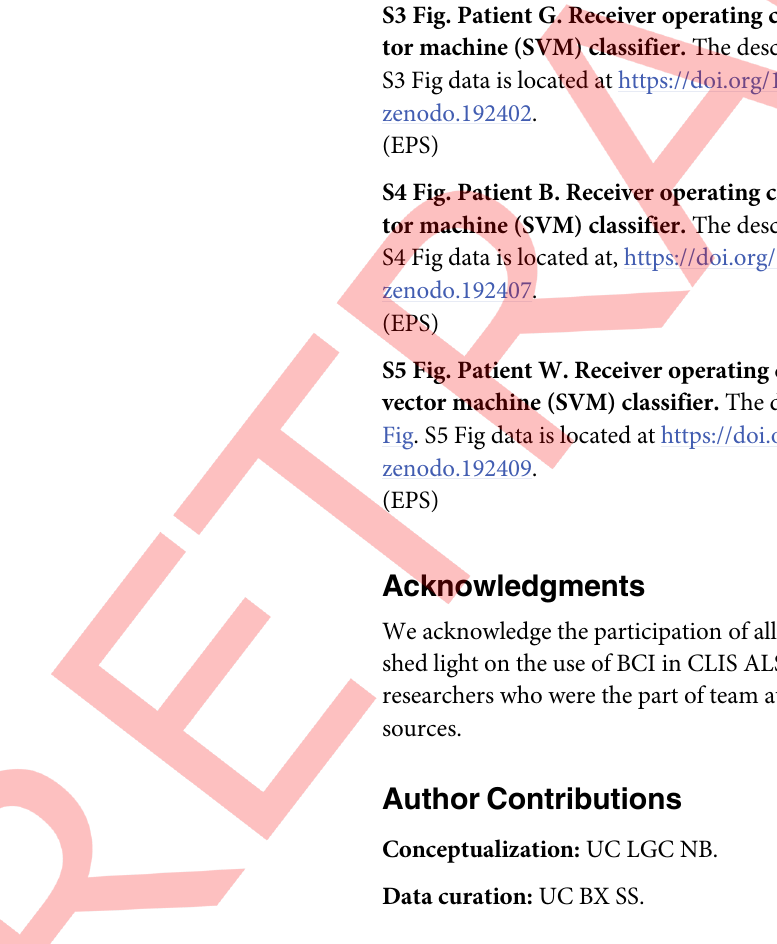
S3 Fig. Patient G. Receiver operating characteristic (ROC) curve of the binary support vec- tor machine (SVM) classifier. The description of this figure is the same as described in S2 Fig. S3 Fig data is located at https://doi.org/10.5281/zenodo.192401; https://doi.org/10.5281/